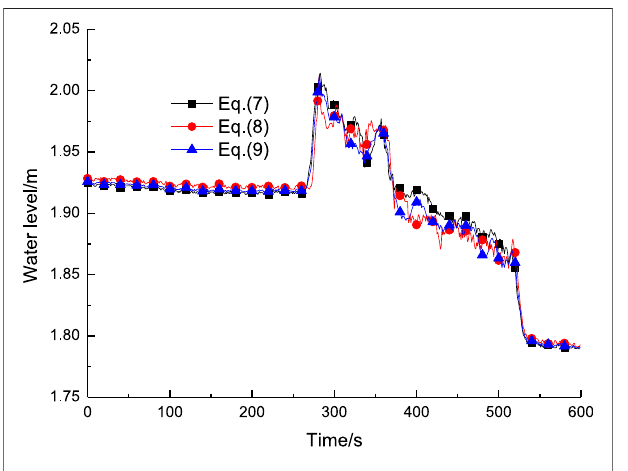
FIGURE 11 | Three channels of slow depressurization.